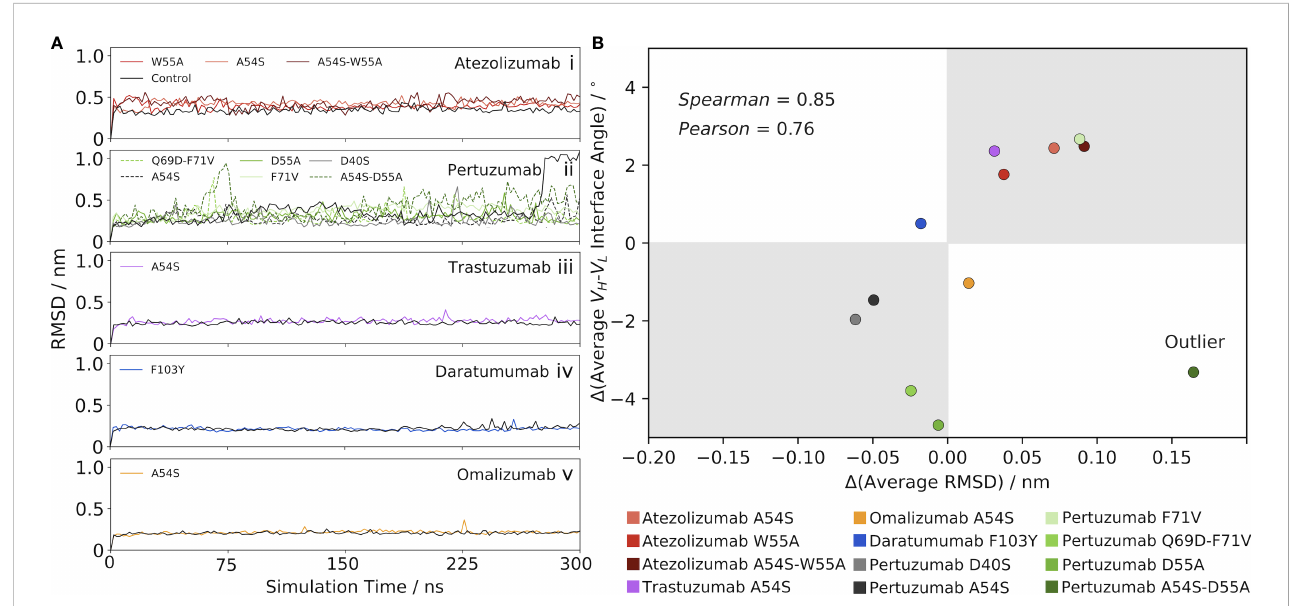
FIGURE 2 Mutation-induced shifts in the V H -V L interface angle away from the control Ab correlate with changes in RMSD from the control. (A) RMSD as a function of simulation time for (i) Atezolizumab, (ii) Pertuzumab, (iii) Trastuzumab, (iv) Daratumumab, and (v) Omalizumab, and their mutants. (B) Correlation between the change in V H -V L interface angle (mutant – control) and change in RMSD (mutant – control). One outlier was identi fi ed via an outlier analysis (see main text) and excluded from the calculation of the reported correlation